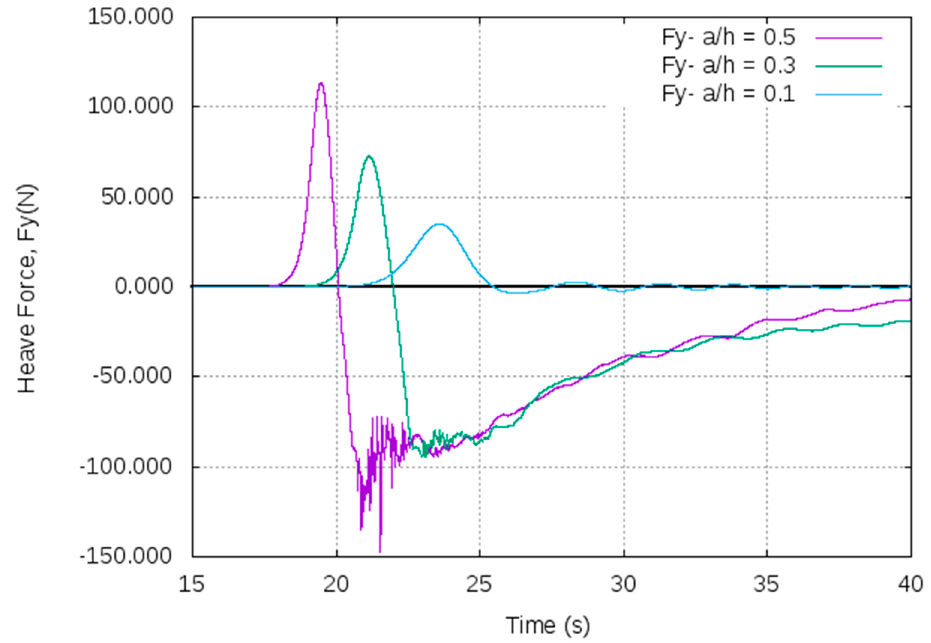
Figure 10. Heave or vertical force experienced by the pontoon while encountering solitary waves (for a / h = 0.1, 0.3, and 0.5).